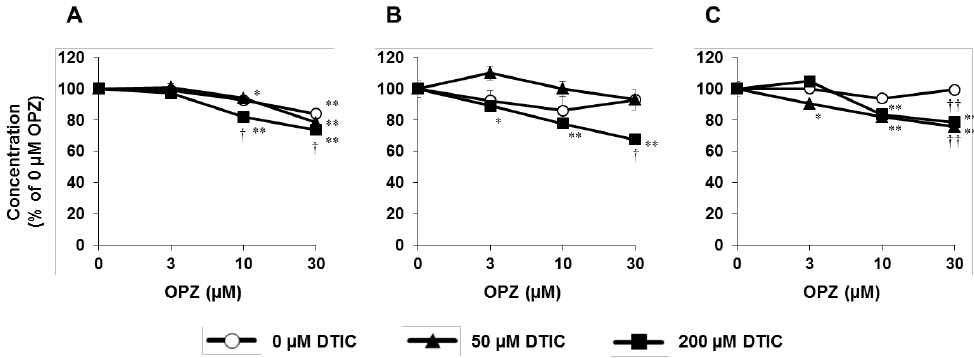
Figure 6. Metabolic toxicity assay using PHH spheroids. The 3D spheroids were exposed to omeprazole (OPZ) (0, 3, 10, or 30 µM) and dacarbazine (DTIC) (0, 50, or 200 µM). Albumin secretion ( A ), urea secretion ( B ), and AST leakage ( C ) were measured. Values are mean ± S.E. ( n = 3). * p <